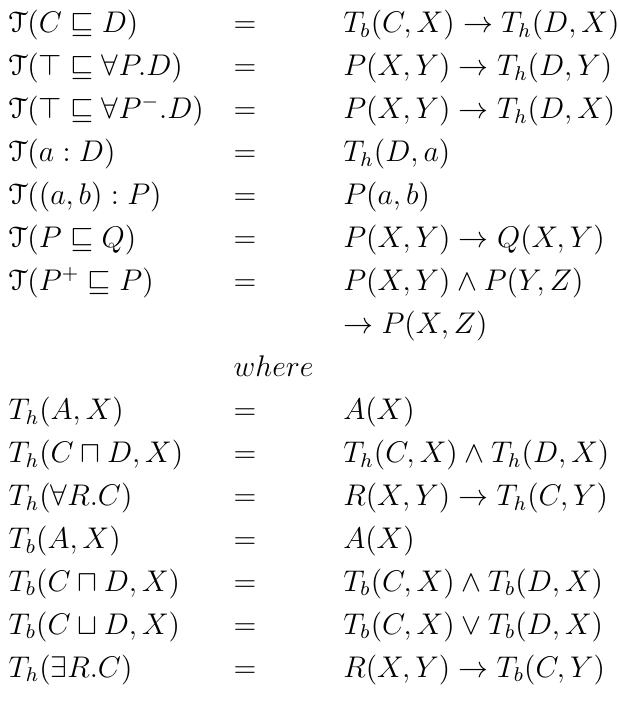
Figure 1. Mapping from DL ontologies into strict